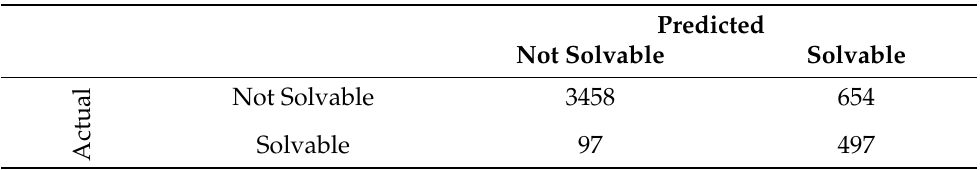
Table 1. Confusion matrix for evaluating the decision tree (Figure 2) on the test dataset. Setting of fixed annealing time and fixed UTC prefactor.